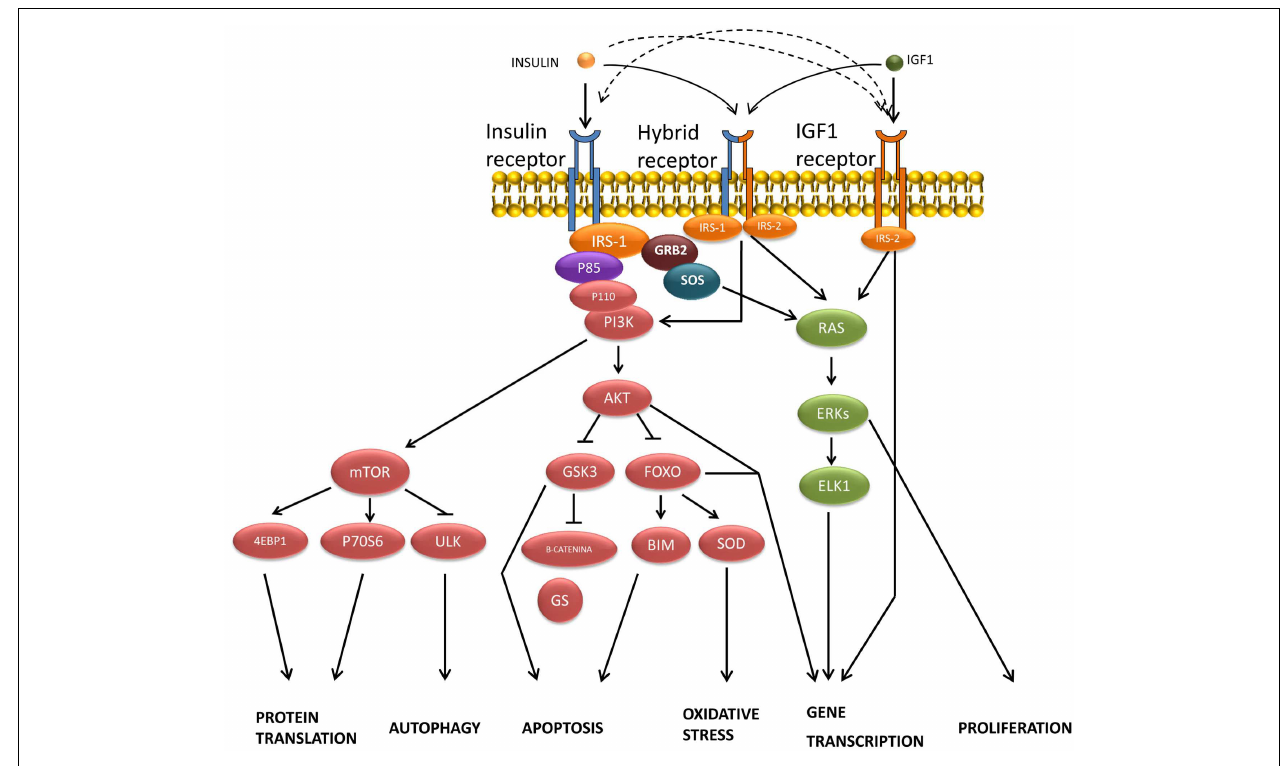
FIGURE 2 |Transduction of signals and biological actions induced by insulin or IGF-1 through their receptor or through their hybrid receptors